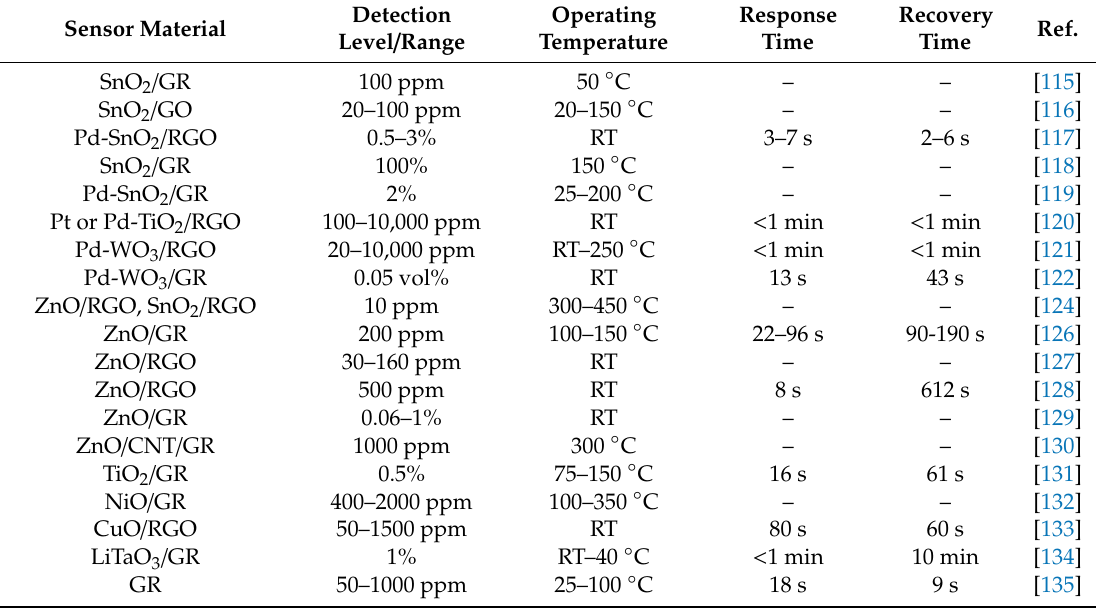
Figure 13. Schematic representation of sensing mechanism [135]. Copyright (2020), with permission from Elsevier. Table 3. Comparison of the H 2 sensors based on graphene and their composites with metal oxides.